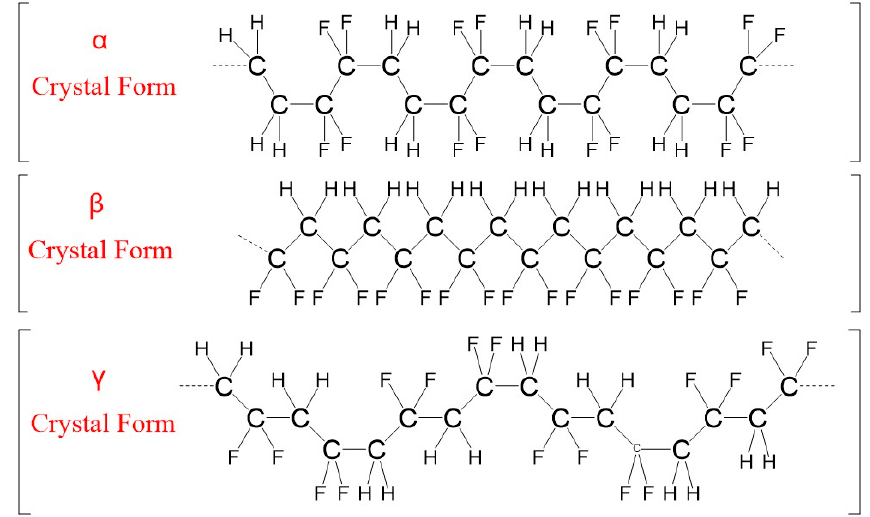
Figure 2. Molecular chain configuration of PVDF crystalline phase.